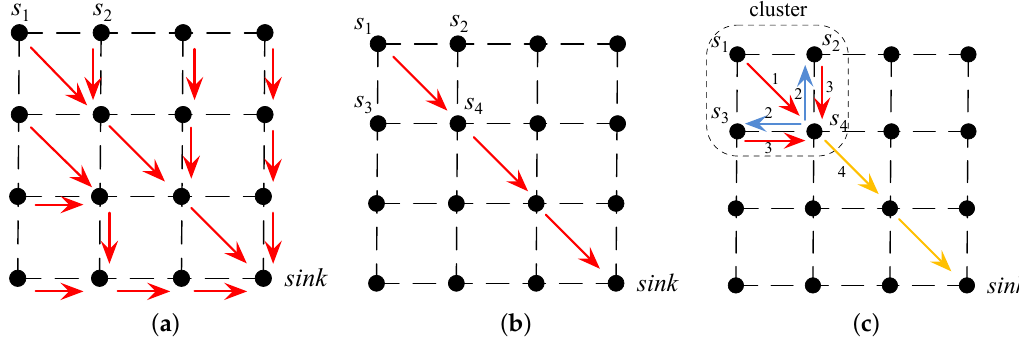
Figure 17. Possible implementation frameworks in wireless sensor networks. ( a ) Centralized query framework. ( b ) Distributed implementation framework for the NN algorithm. ( c ) Distributed implementation framework for the MS or BIB